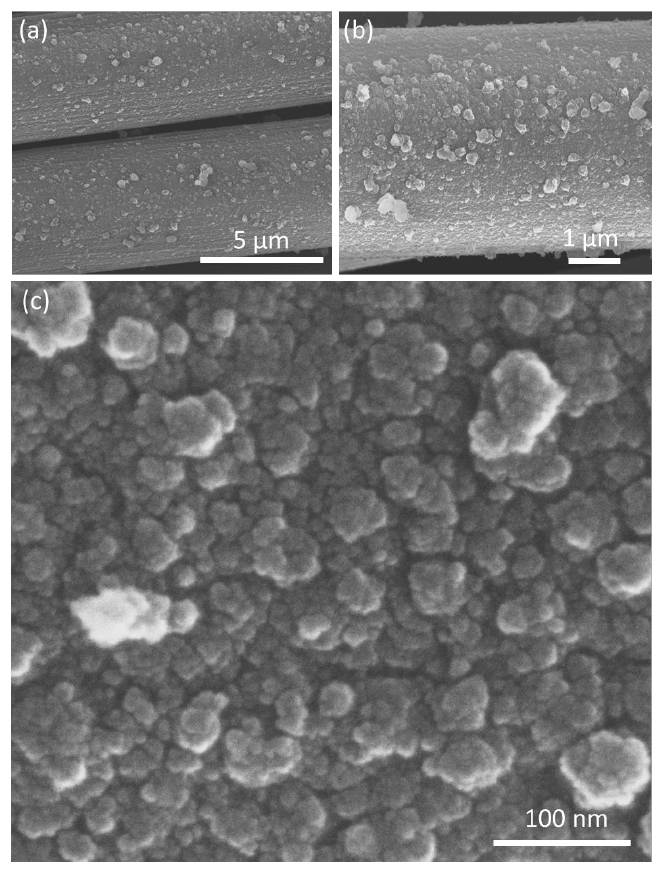
Figure 2. FESEM images of MnO 2 -NPs@CC. ( a , b ) low- and ( c ) high-magnification.